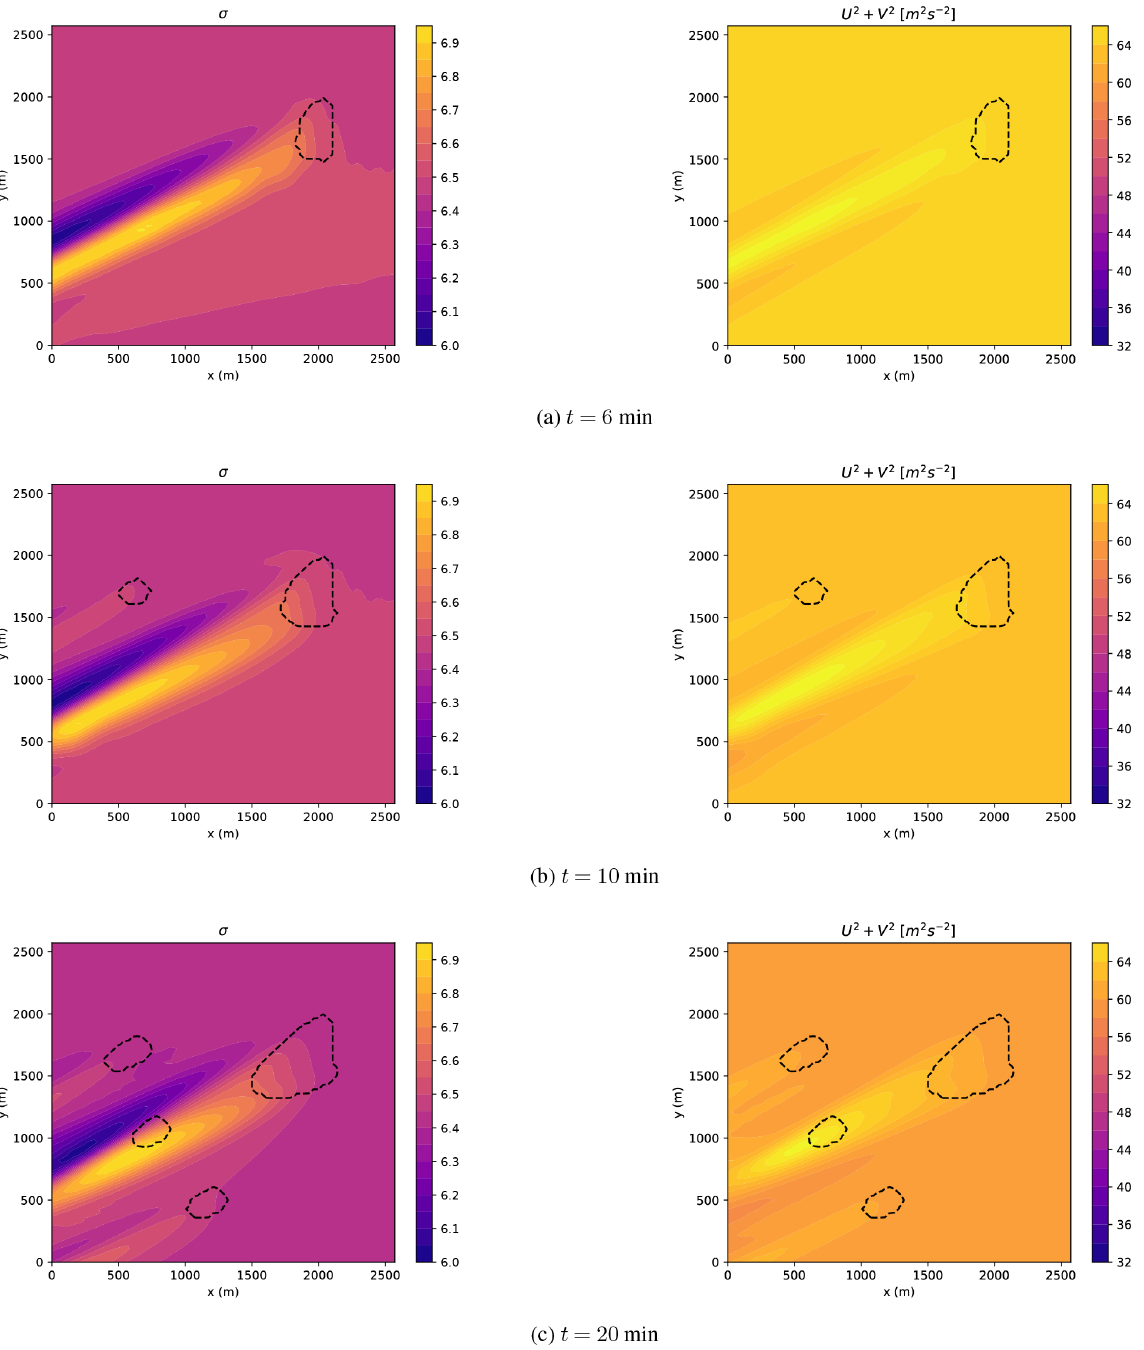
Figure 3. The PDF shape parameter σ and horizontal wind squared magnitude ( | U h | 2 ) performed with WRF-SFIRE at times t = 6, 10 and 20min. The fire front is represented by a dashed